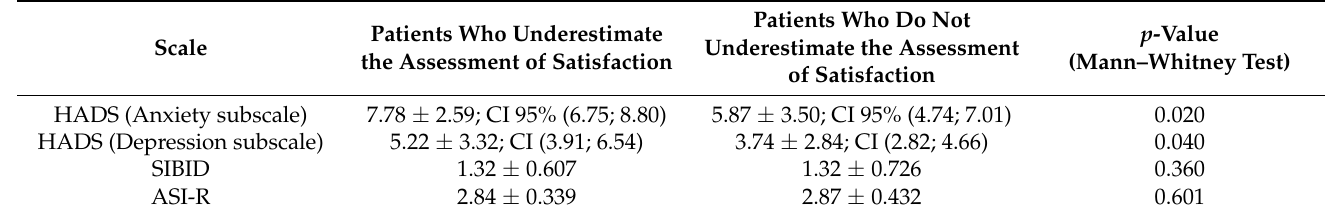
Table 9. The results of the assessment of the psycho-emotional status in patients who underestimate and do not underestimate the assessment of satisfaction with the result (M ± SD).